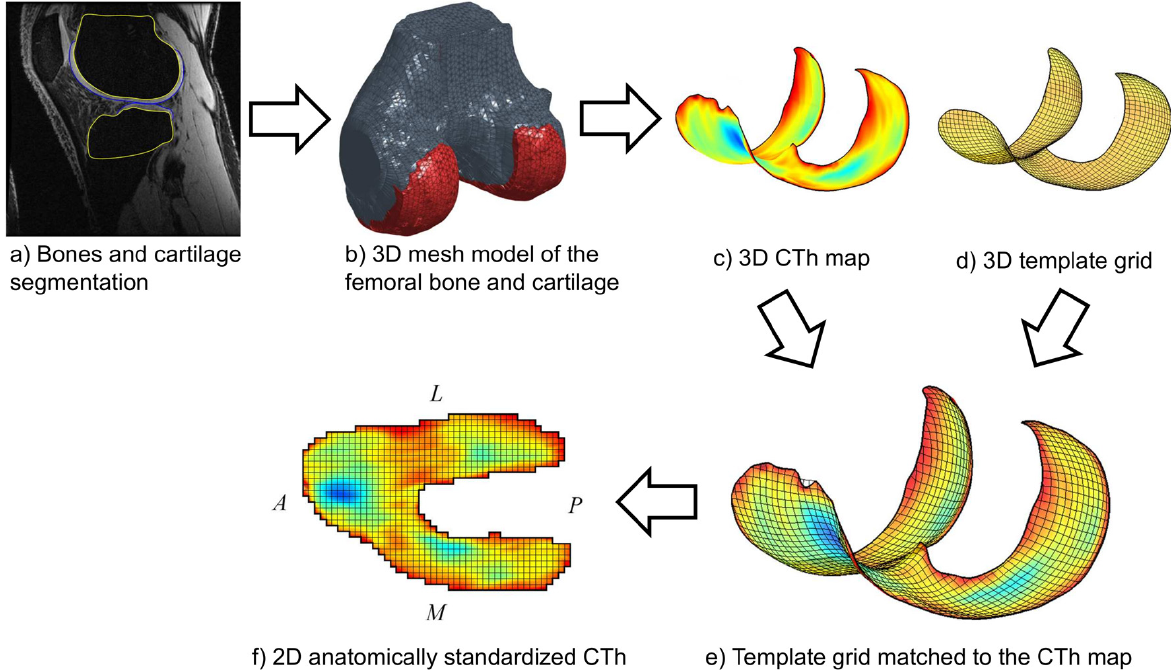
Figure 1. Illustration of the method ( a – f ) yielding the femoral 2D anatomically standardized CTh maps. The same method applies for the tibia. The A, P, L and M letters indicate the anterior, posterior, lateral and medial directions, respectively.